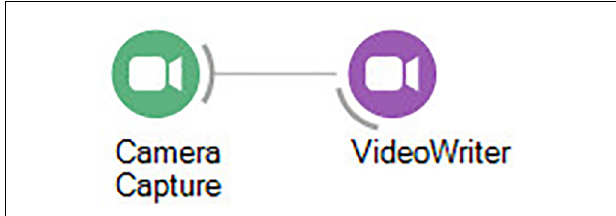
FIGURE 2 | Bonsai workflow for recording video from a single camera.